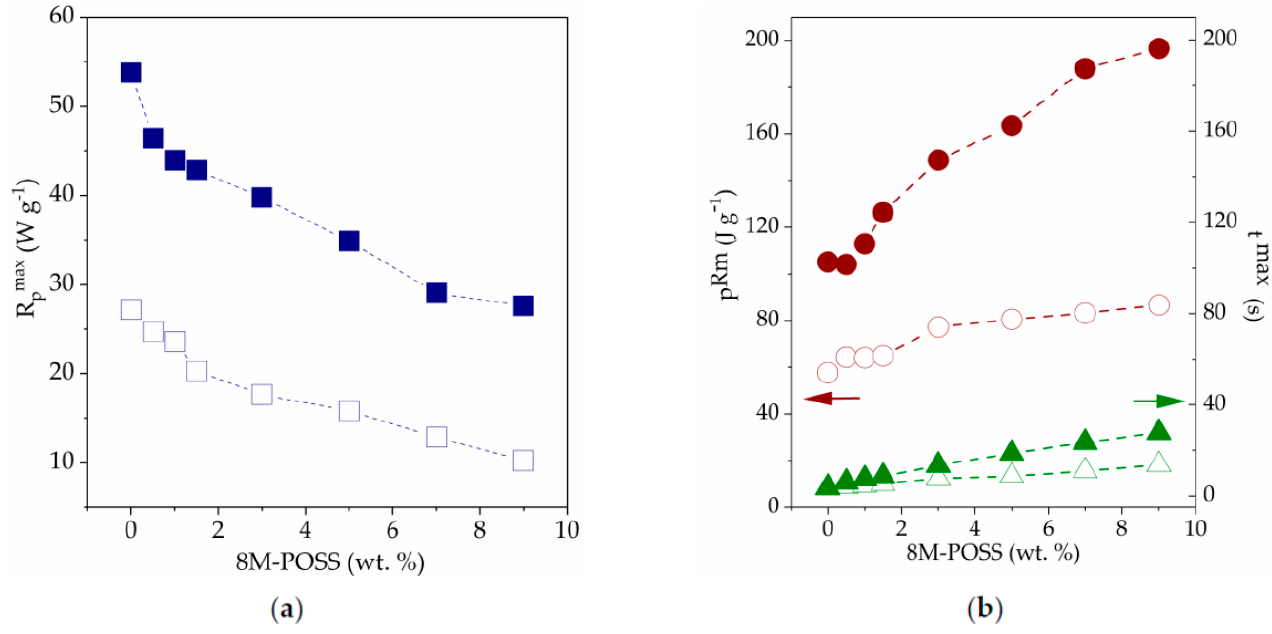
Figure 5. ( a ) Maximum polymerization rate ( R pmax ), and ( b ) time at R pmax ( t ma x , triangles) and conversion at R pmax ( p Rm , circles) as a function of 8M-POSS content in investigated system (TATT + PETMP + 8M-POSS) with (full symbols) and without (open symbols) solvents mixture (EMImNTf 2 + PC).